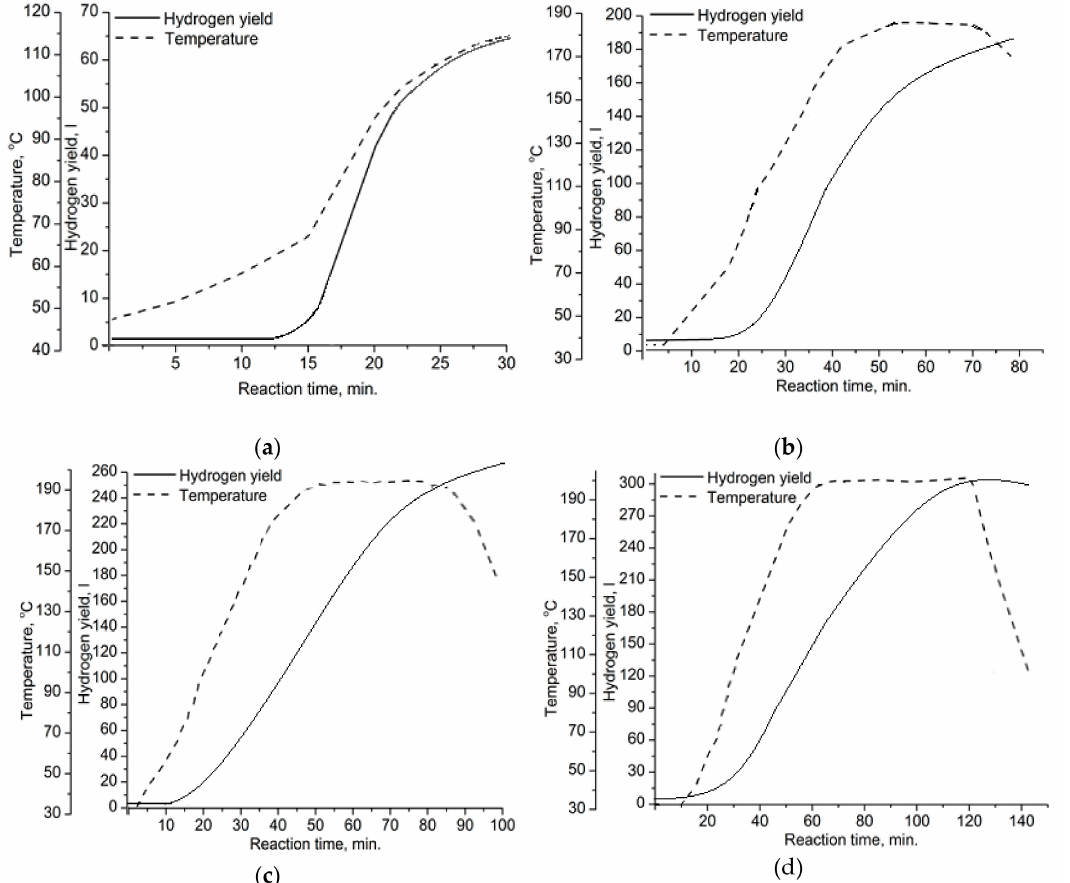
Figure 4. Yield of the released hydrogen and reaction temperature vs. reaction time for the following oxidation modes: ( a ) A, ( b ) B, ( c ) C, ( d )